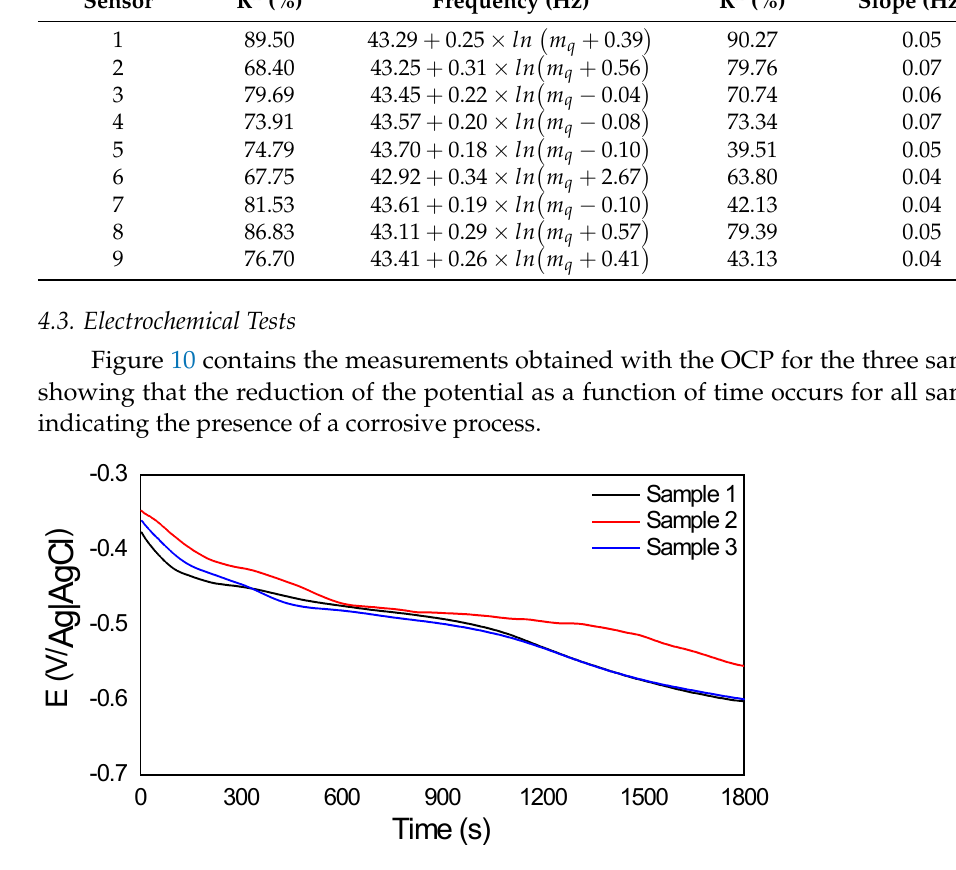
Figure 10. OCP curves for samples 1, 2, and 3 of 1020 carbon steel in NaCl solution.